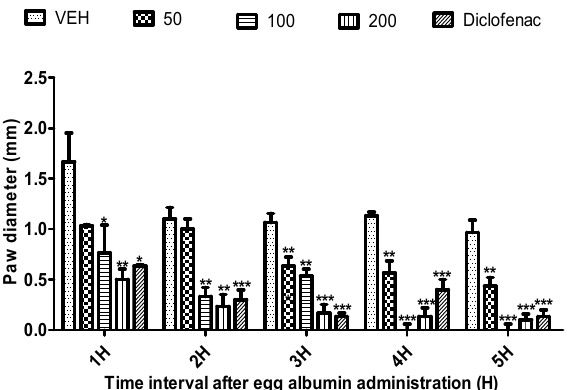
Figure 4. Effect of “Rose Pink” grapefruit ( C. paradisi ) fresh leaves essential oil on egg albumin- induced rat paw oedema. Results are expressed as Mean ± SEM. VEH, ECH and ASA represent vehicle (5% Tween 80), Rose leaves essential oil (FRLG) and diclofenac, respectively. * p < 0.05, ** p < 0.01 and *** p < 0.001, statistically different from negative control group (ANOVA, Dunnett’s).